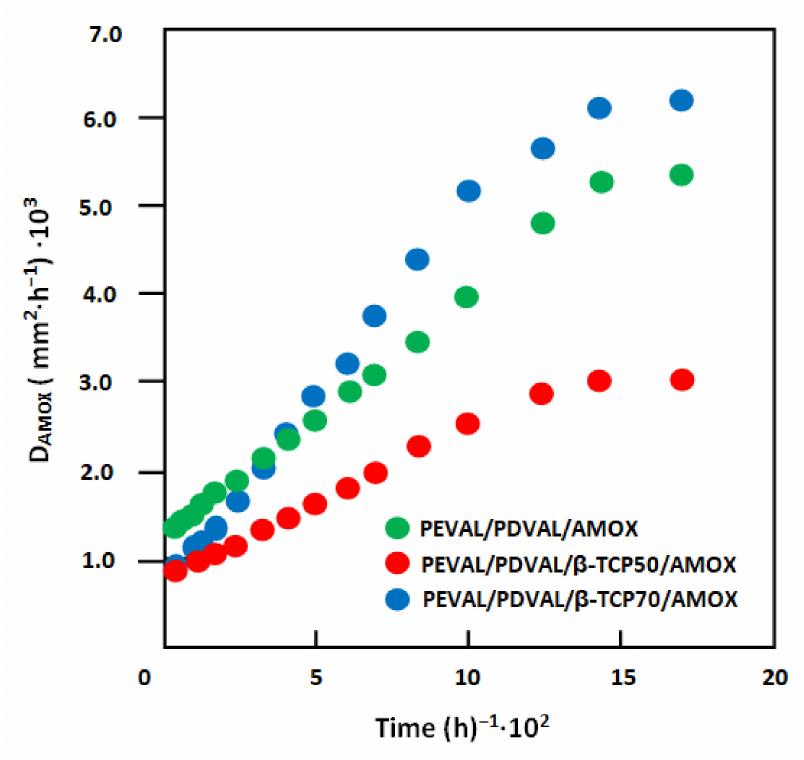
Figure 13. Variation of amoxicillin’s diffusion coefficient through the PEVAL/PDVAL/ β - TCP/amoxicillin drug carrier systems with different β -TCP contents versus the inverse of time (revoir β